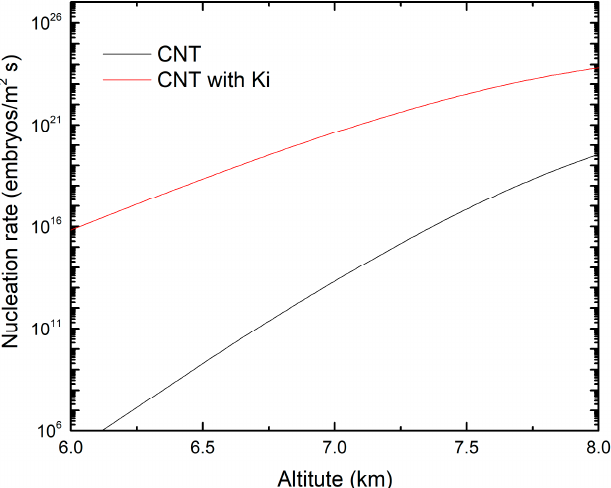
Figure 9. Nucleation rate (embryos/(m 2 s)) versus altitude in the atmosphere using CNT and a revised CNT theory including a surface tension correction factor during immersion freezing for pre-existing particles (r p = 1 µ m) with a contact angle θ = 60°.